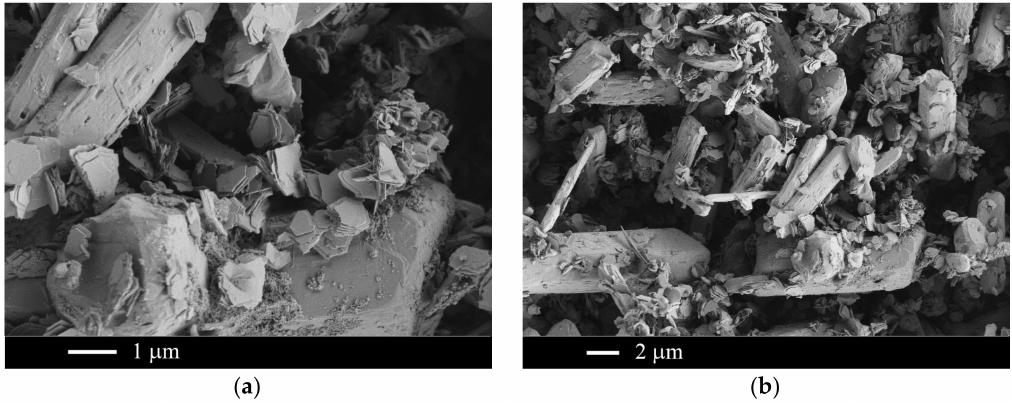
Figure 6. SEM images of sample 7 in the NaF–CeF 3 system (Ce(NO 3 ) 3 :NaF:NaNO 3 = 4:53:43 ratio of starting materials) synthesized at 400 ◦